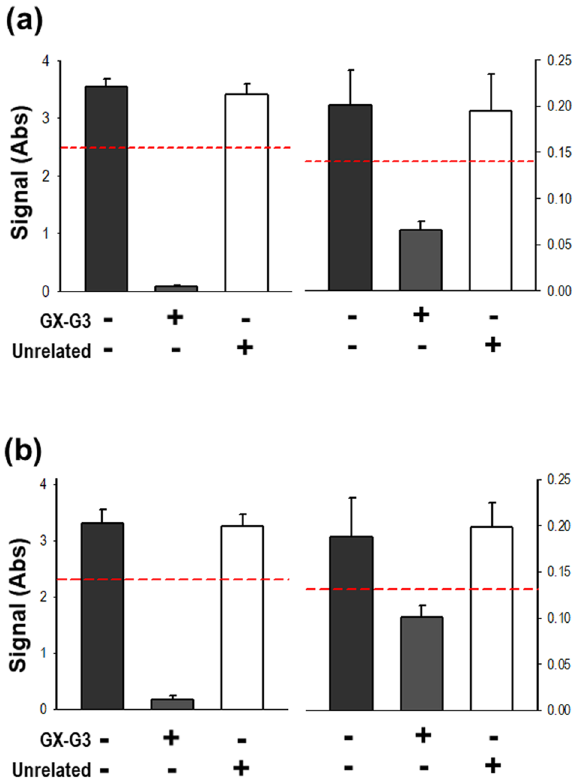
Figure 4. Specificity confirmation assay. PC were characterized by testing immune-competition for specificity confirmation. High- and low-concentration PC were pre-incubated for 1 h with the drug GX-G3 or a comparator molecule considered to be unrelated to G-CSF binding, such as rh-GH. ( a ) High- and low- concentration PC were spiked into pooled rat serum samples at concentrations of 200 μg/mL and 0.4 μg/ mL, respectively. ( b ) High- and low-concentration PC were spiked into pooled monkey serum samples at concentrations of 250 μg/mL and 0.4 μg/mL, respectively. High- and low-concentration PC were pre-incubated with 150 μg/mL GX-G3 for rat serum or 200 μg/mL GX-G3 for monkey serum. rh-GH was used as an unrelated antigen and was spiked into the samples at the same concentrations as GX-G3. High-concentration PC, high- concentration positive control samples; Low-concentration PC, low-concentration positive control samples; Unrelated, unrelated antigen; rh-GH, recombinant human growth